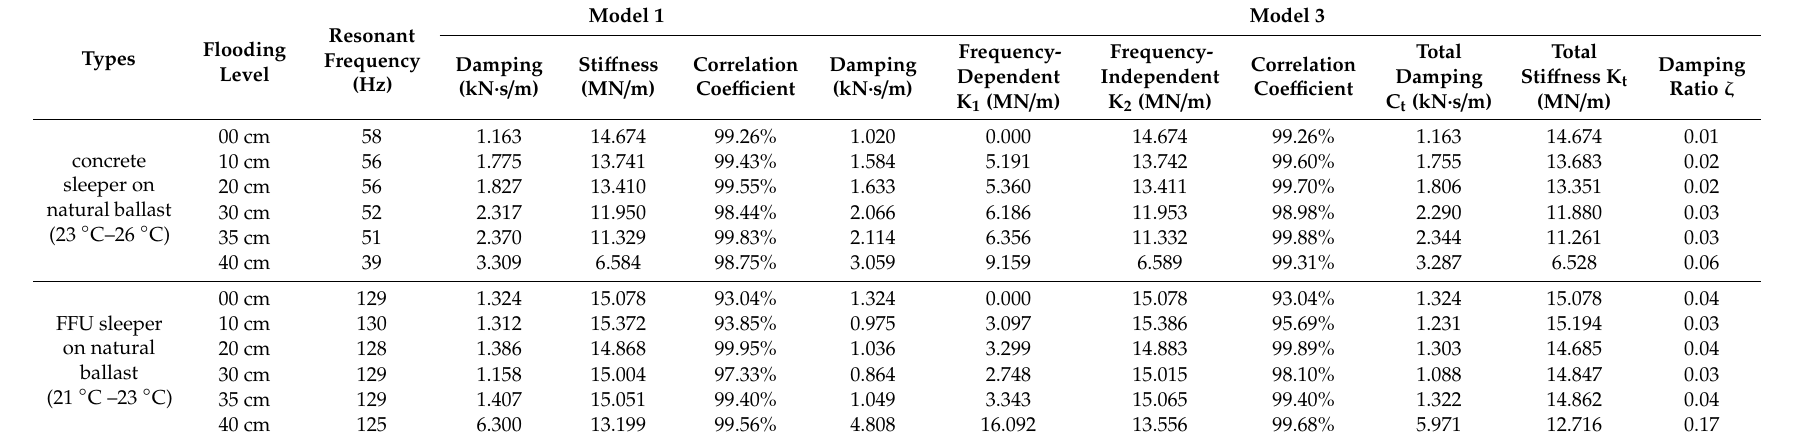
Table A1. Comparison of the dynamic properties of railway ballast in flood.